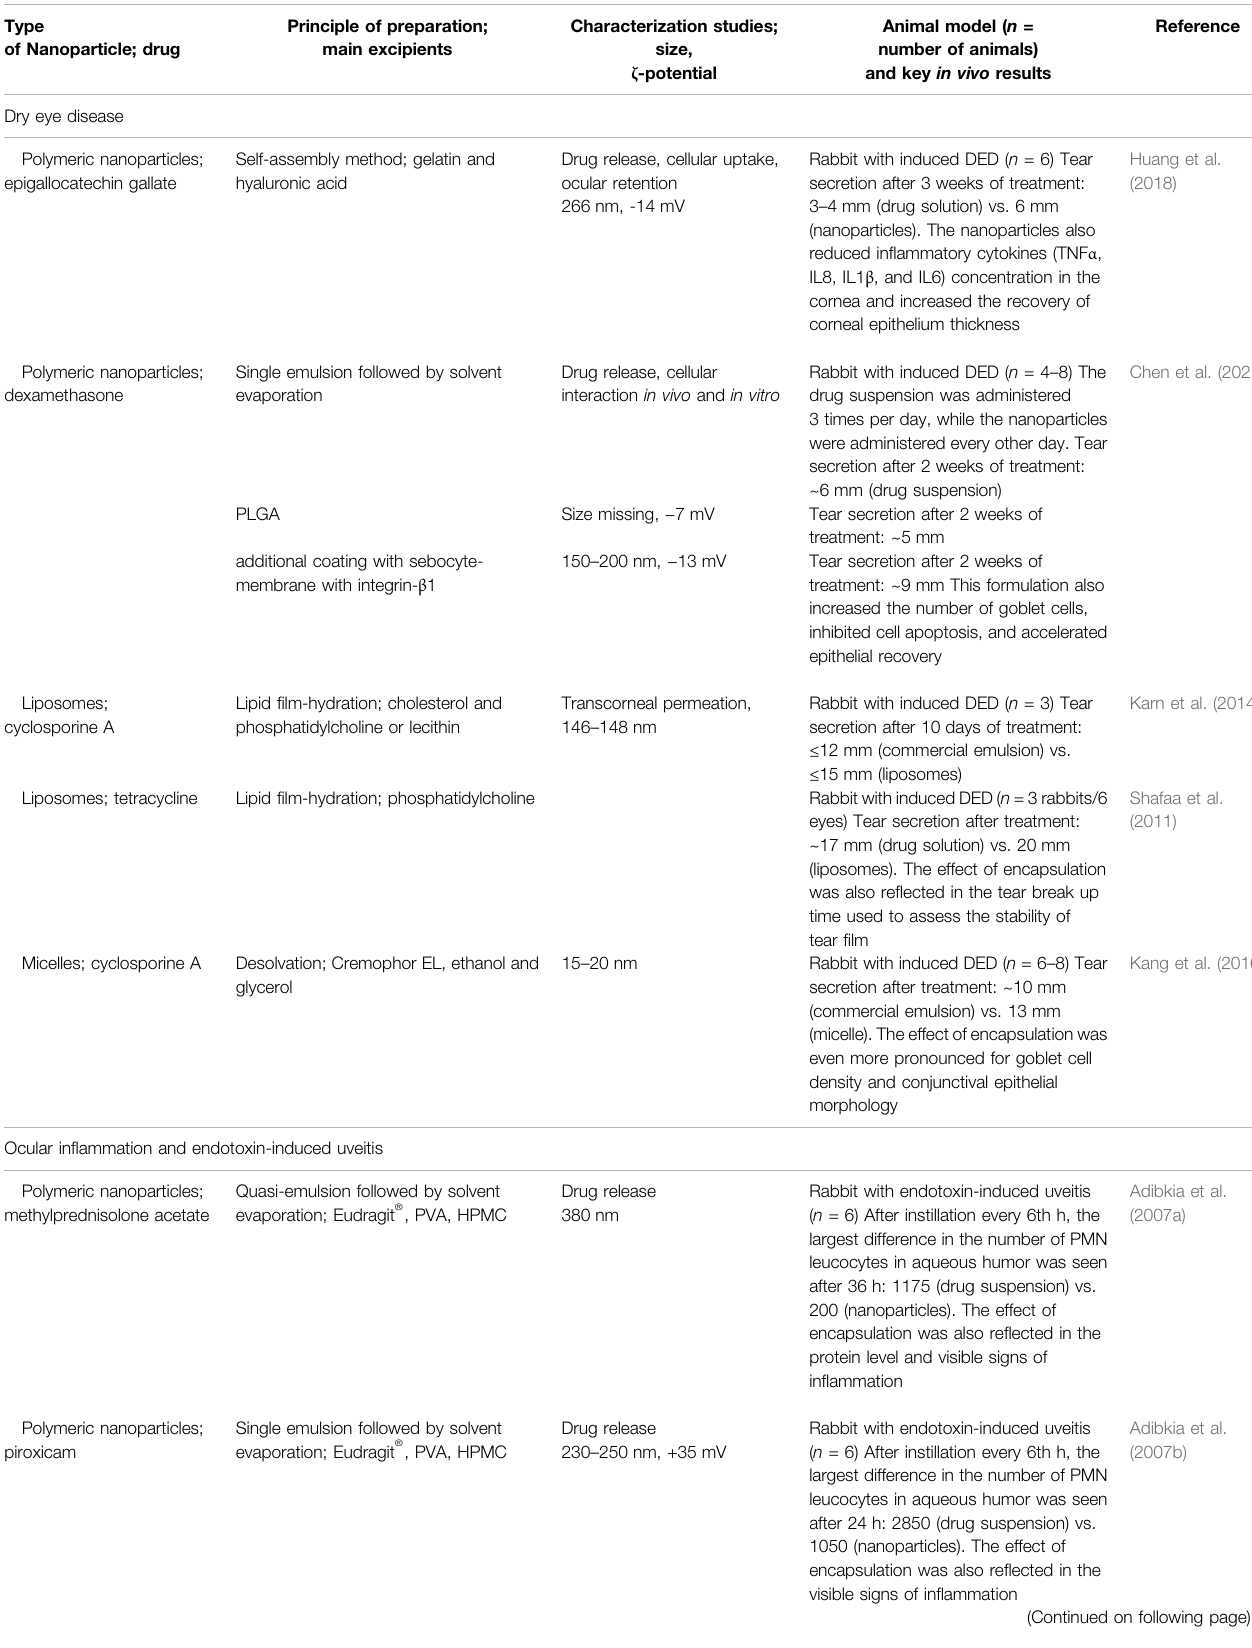
TABLE 4 | ( Continued ) Summary of in vivo studies on nanoparticle-based systems used for drug delivery to anterior segment of the